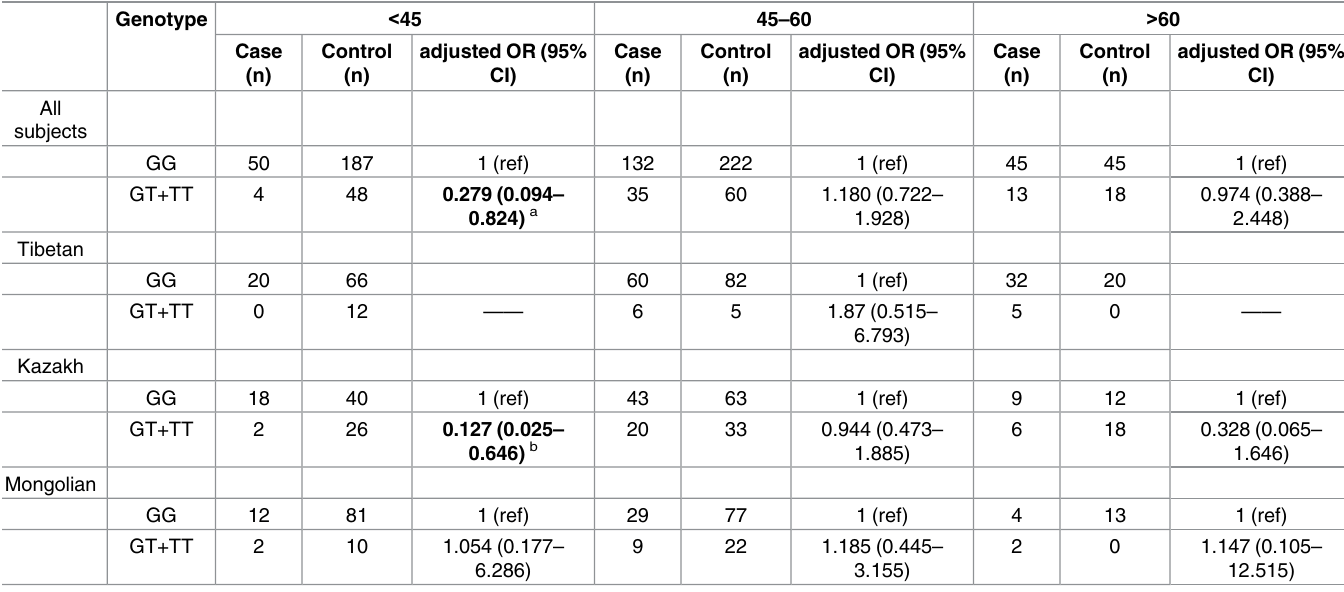
Table 4. Associations between skeletal fluorosis and the PRL rs1341239 genotype in different age groups (overall or stratified by ethnicity).